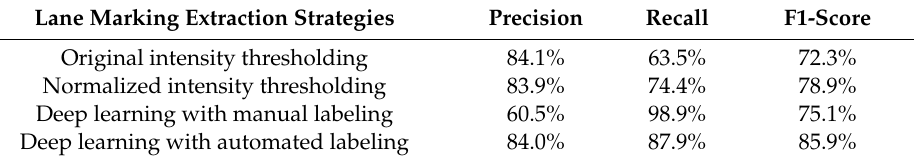
Figure 20. Training and validation loss curves for ( a ) U-net model 1 and ( b ) U-net model 2. Table 7. Performance metrics for the lane marking extraction strategies in dataset